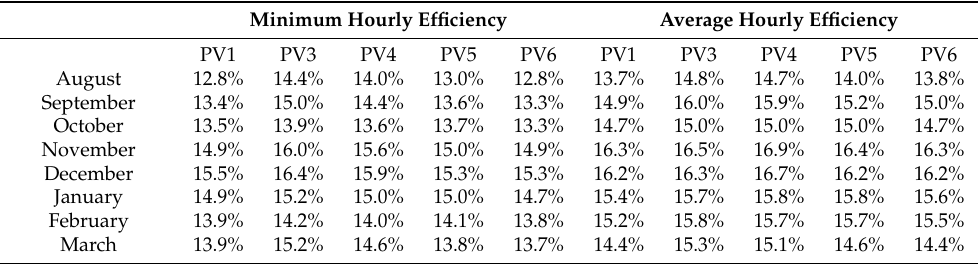
Table 4. Values of daily minimum and daily average efficiency of the different cooled modules for the sunny days selected for the analysis.